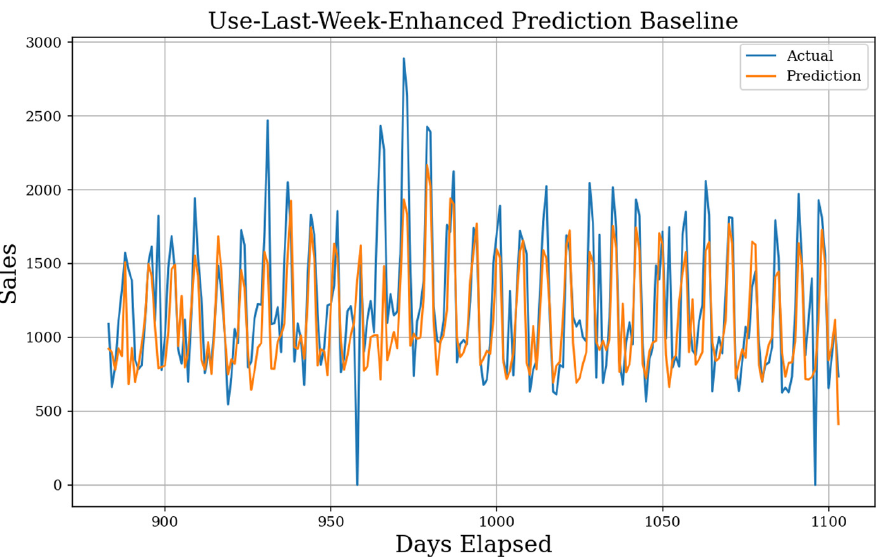
Figure 11. Enhanced Use-Last-Week Actual Prediction. Using the weekly seasonality and the mean weekday average, the final prediction baseline implements a simple history. The MAE baseline generated is 239, the sMAPE is 21.5%, and the gMAE is 150.